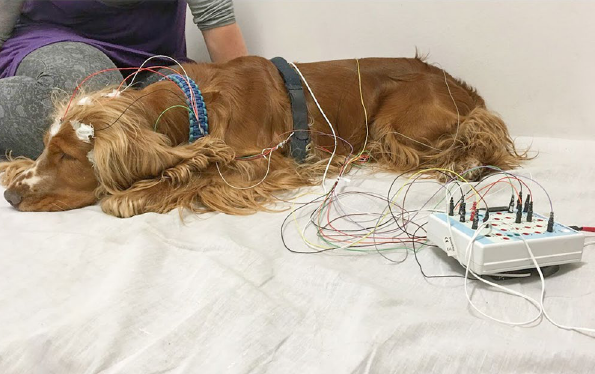
Figure 4. Photo of a dog with electrode placement. Electrode placement involved attachment of EEG and EOG electrodes on the scalp, ECG electrodes bilaterally over the second rib, and EMG electrodes bilaterally on the musculus iliocostalis dorsi. Respiration was recorded via a chest respiratory